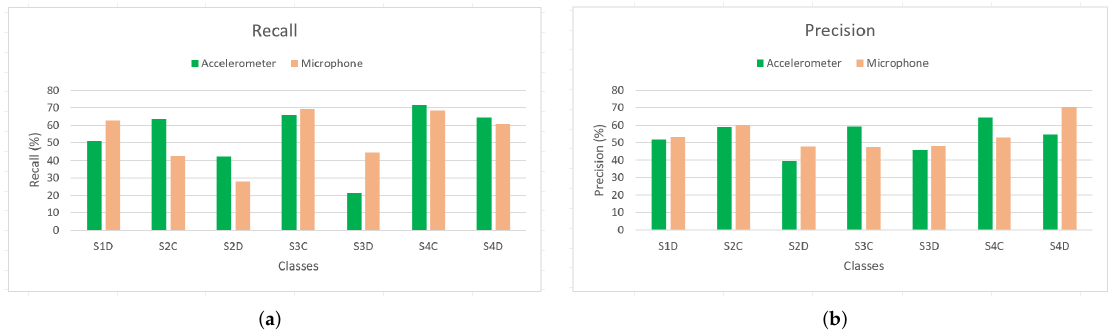
Figure 9. The DCNN models inferences in terms of recall and precision. ( a ) Recall. ( b ) Precision.